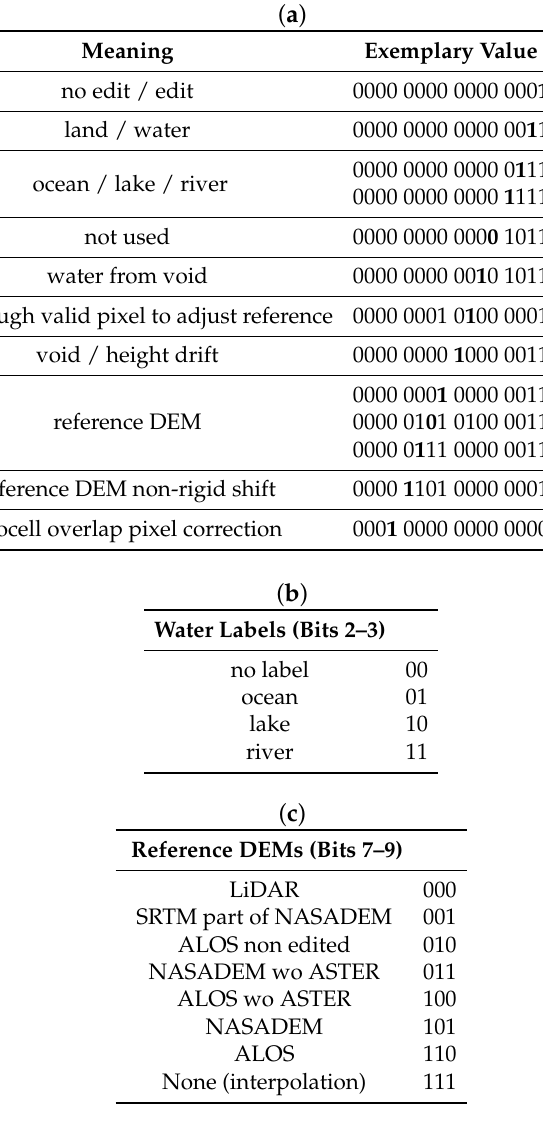
Table 1. Editing mask. ( a ) Summary of the utilized bits and examples of their coding and meaning. ( b ) Water label coding associated to bits 2 and 3. ( c ) Coding of bits 7–9, identifying the used external reference DEMs for gap